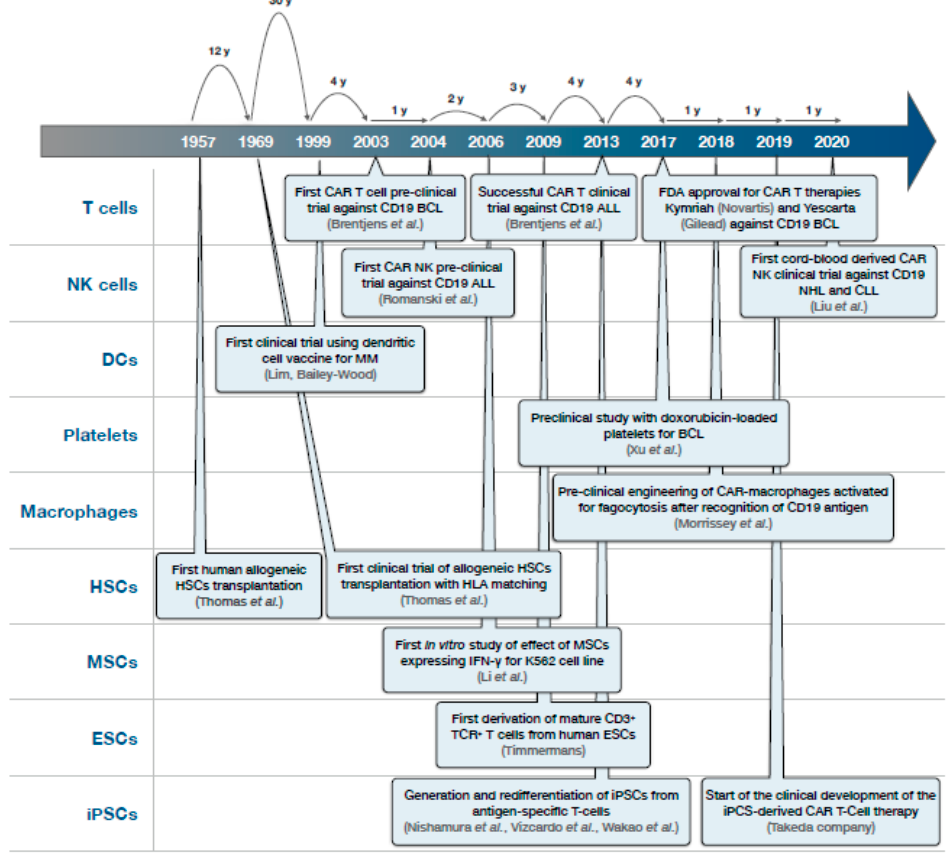
Figure 2. Timeline of cancer cell-based therapy milestones in the past 70 years in blood cancer treatments. ALL: acute lymphoblastic leukemia, BCL: B cell lymphoma, CLL: chronic lymphocytic leukemia, ESCs: embryonic stem cells, NHL: Non-Hodgkin’s lymphoma, MM: multiple